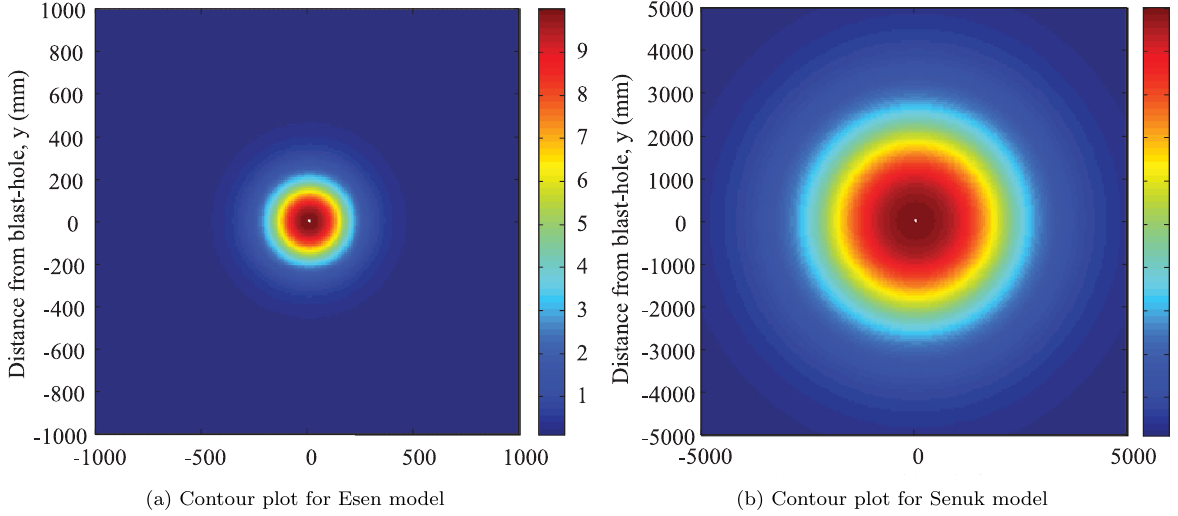
Figure 4. Contour plot of the exceedance probability of crushed Figure 1: Histogram of generated random samples for (a) H e , (b) H t , (c) L , and (d) δ R zone radius around the explosion point based on Esen ’ s model. Figure 6. Contour plot of exceedance probability around the explosion point based on (a) Szuladzinski ’ s, (b) Djordjevic ’ s, (c) Senuk ’ s, and (d) modi fi ed Ash ’ s models. Table 5. Exceedance probability for di ff erent cases.